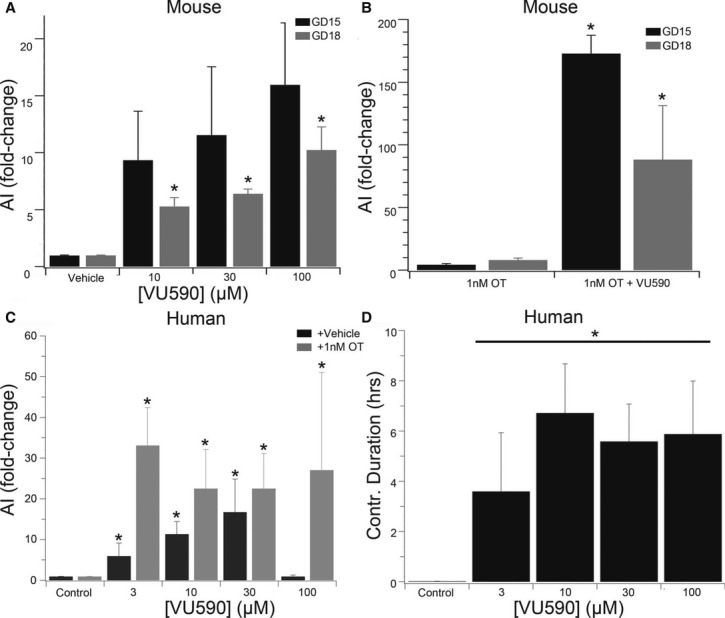
Pharmacological inhibition of Kir7.1 in vitro in human and murine myometrium stimulates longer-lasting contractions than oxytocinDose- and gestation-dependent effect of VU590 on murine myometrial contractility [n = 5, activity integral expressed as a fold-change of pre-treatment contractions (mean ± SD, per GD)]. *P < 0.05 GD18 vs GD15 per dose by ANOVA with Tukey's post hoc test.As in (A) but comparing the effect of 1 nM oxytocin with 1 nM oxytocin + 10 μM VU590. *P < 0.05 OT vs OT = VU590 per GD by Student's t-test.Dose-dependent effect of VU590 (Black Bars) and VU590 + 1 nM oxytocin (grey bars) on human myometrial contractility (n = 8; activity integral expressed as fold-change over pre-treatment contractions, mean ± SD). *P < 0.05 compared to control by ANOVA with Tukey's post hoc test.Dose-dependent effect of VU590 on contraction duration in human myometrial strips taken at term (n = 8, mean ± SD). *P < 0.05 compared to control by ANOVA with Tukey's post hoc test.